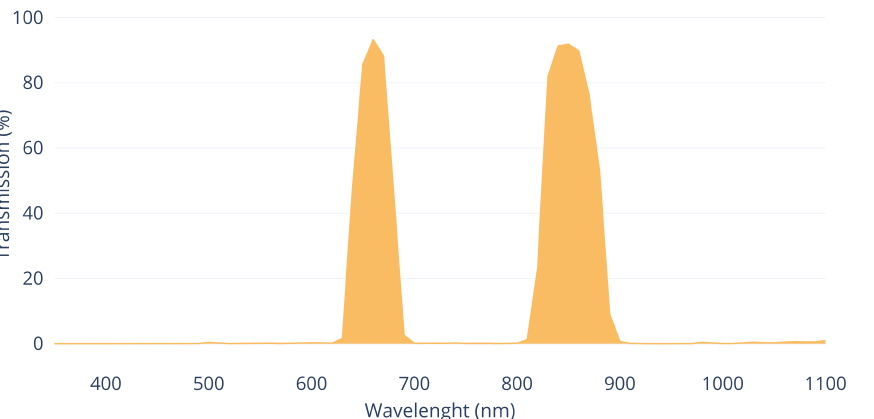
Figure 6. Midopt DB 660/850 Dual Bandpass filter light transmission curve (Source: Midwest Optical Systems,